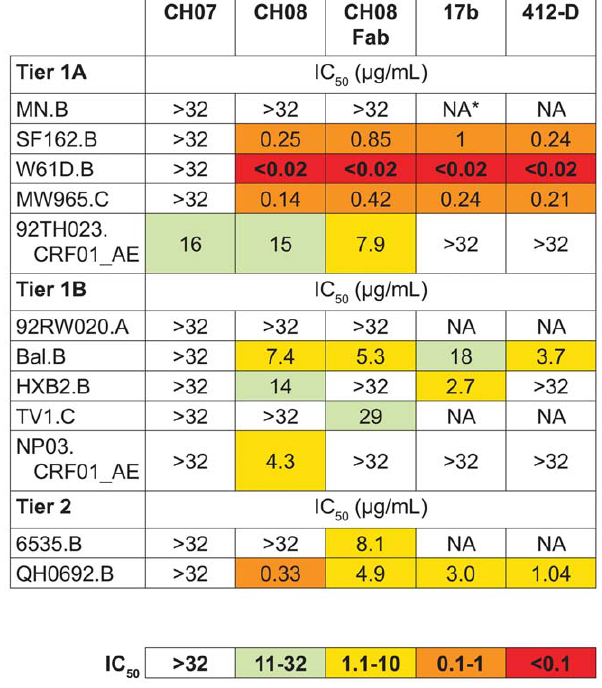
Figure 2. HIV-1 pseudovirus neutralization by mAbs CH07 and CH08. A panel of tier 1 and tier 2 HIV-1 pseudoviruses were tested against mAbs CH07, CH08, 17b, and 412-D in TZM-bl cells. CH07 weakly neutralized a single virus (92TH023.CRF01_AE). In contrast, CH08 neutralized multiple tier 1 and tier 2 viruses in a pattern similar to that of CD4i mAbs 17b and 412-D. A fragment (Fab) of CH08 neutralized with a potency similar to that of the intact mAb, suggesting that the binding site for mAb CH08 was not inaccessible for most of the isolates tested. An additional panel of 13 tier 2 viruses was not neutralized by any mAb